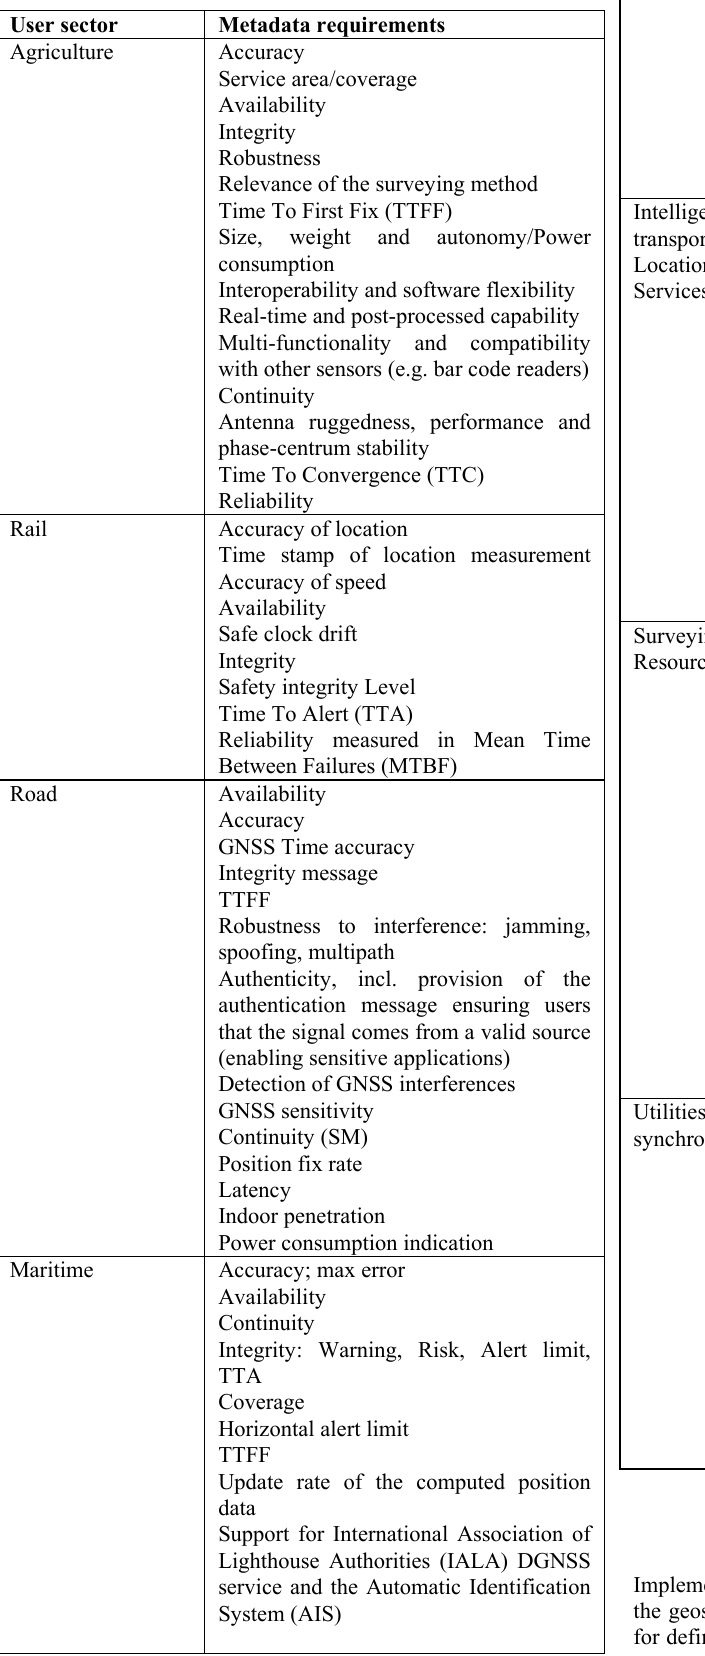
Table 1 Users and their metadata requirements on precise positioning